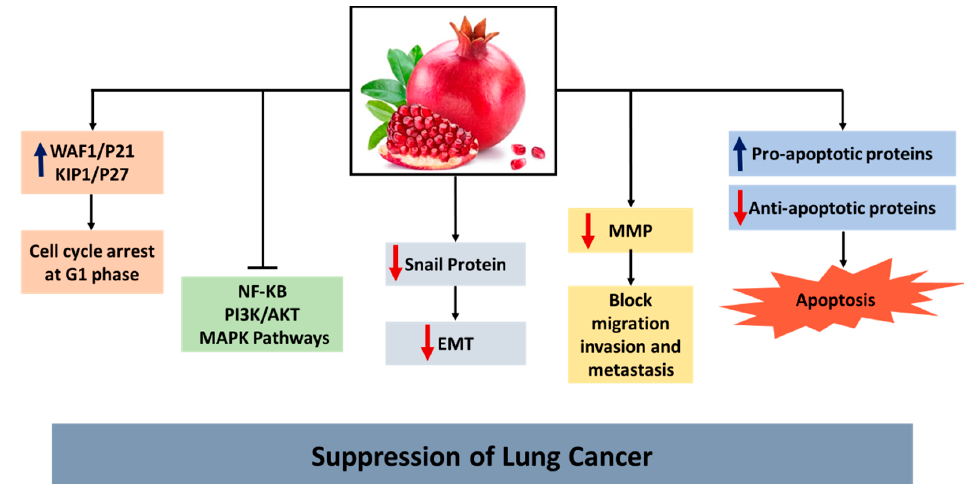
Figure 5. Pomegranate activity in lung cancer